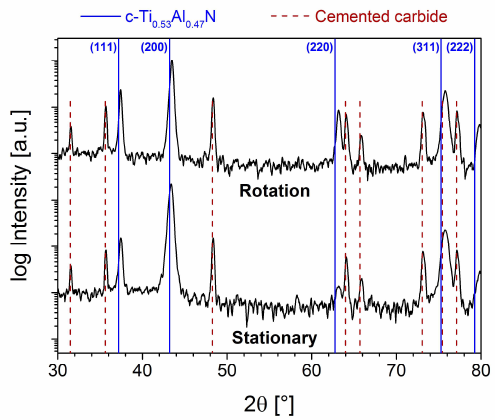
Figure 2. X-ray diffractograms of TiAlN, synthesized with substrate rotation and stationary deposition geometry on cemented carbide substrates (10 µm thickness).